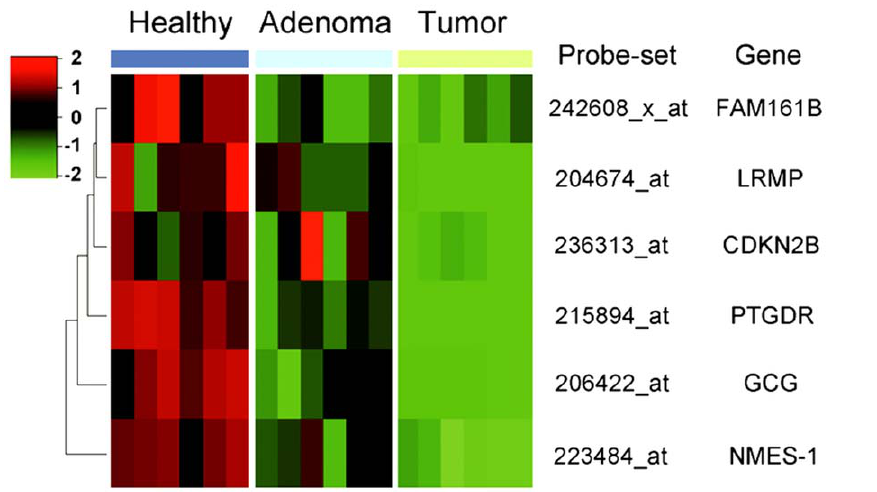
Figure 2. Differential expression of six selected genes in normal colonic epithelial samples, adenoma, and tumor samples. Expression of the tumor suppressor gene CDKN2B is shown for comparison. Probe set identification codes and gene names are indicated on the right. The six columns indicate microarray results obtained from six individual samples for each type of tissues. Black squares indicate that gene expression was unchanged in that experiment. The degree of intensity of red or green indicates the level of gene expression high or low,